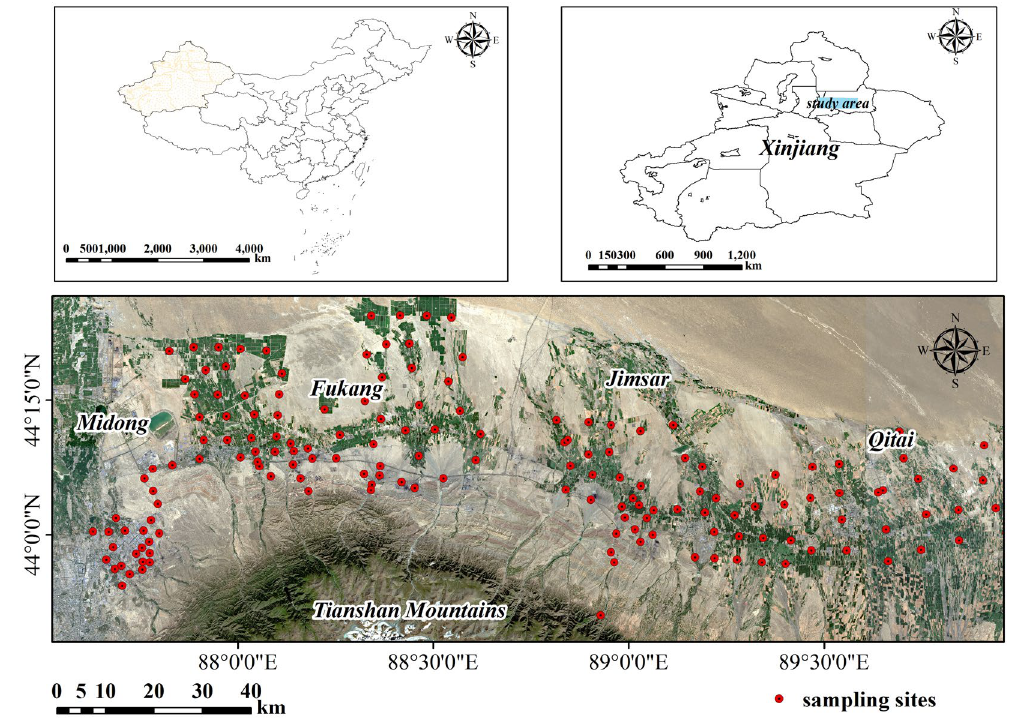
Figure 1. Sketch map of the study area. Map generated with ArcGIS 10.7 (ESRI).URL: https:// suppo rt. esri. com/ en/ Produ cts/ Deskt op/ arcgis- deskt op/